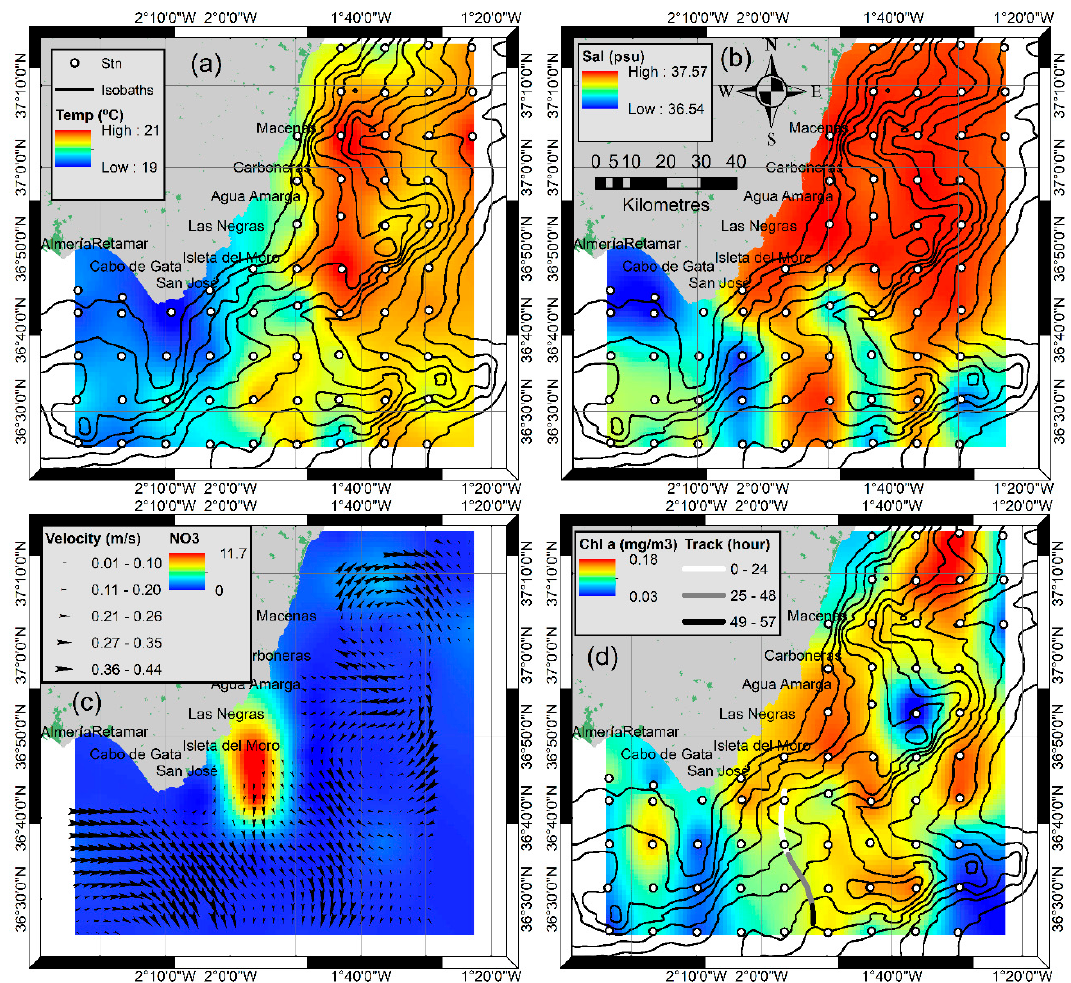
Figure 2. Spatial patterns at 7-m depth of ( a ) temperature ( ◦ C), ( b ) salinity, ( c ) nitrate concentration ( µ M) and horizontal currents (m · s − 1 ), and ( d ) chlorophyll a concentration (mg · m − 3 ) and horizontal particle track from longitude 1.942 W and latitude 36.722 N (Station (Stn) 52) at 7-m depth.